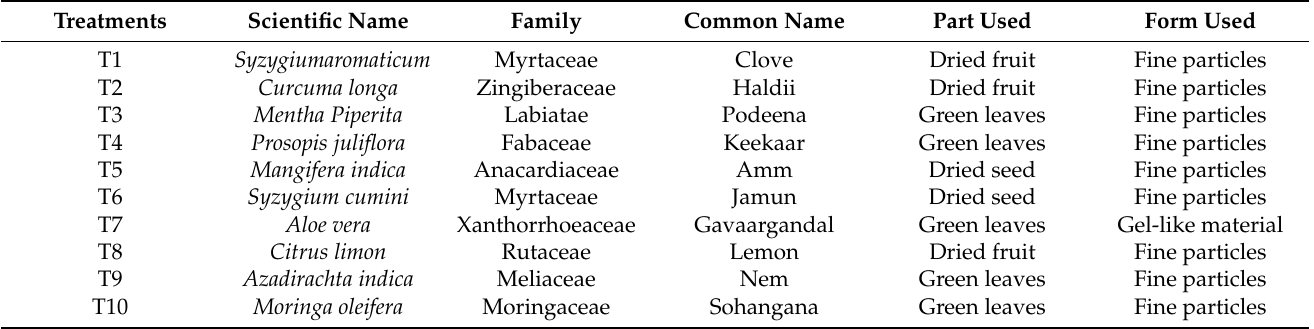
Table 3. List of indigenous plants species/biomolecules collected to evaluate against the bacterium.